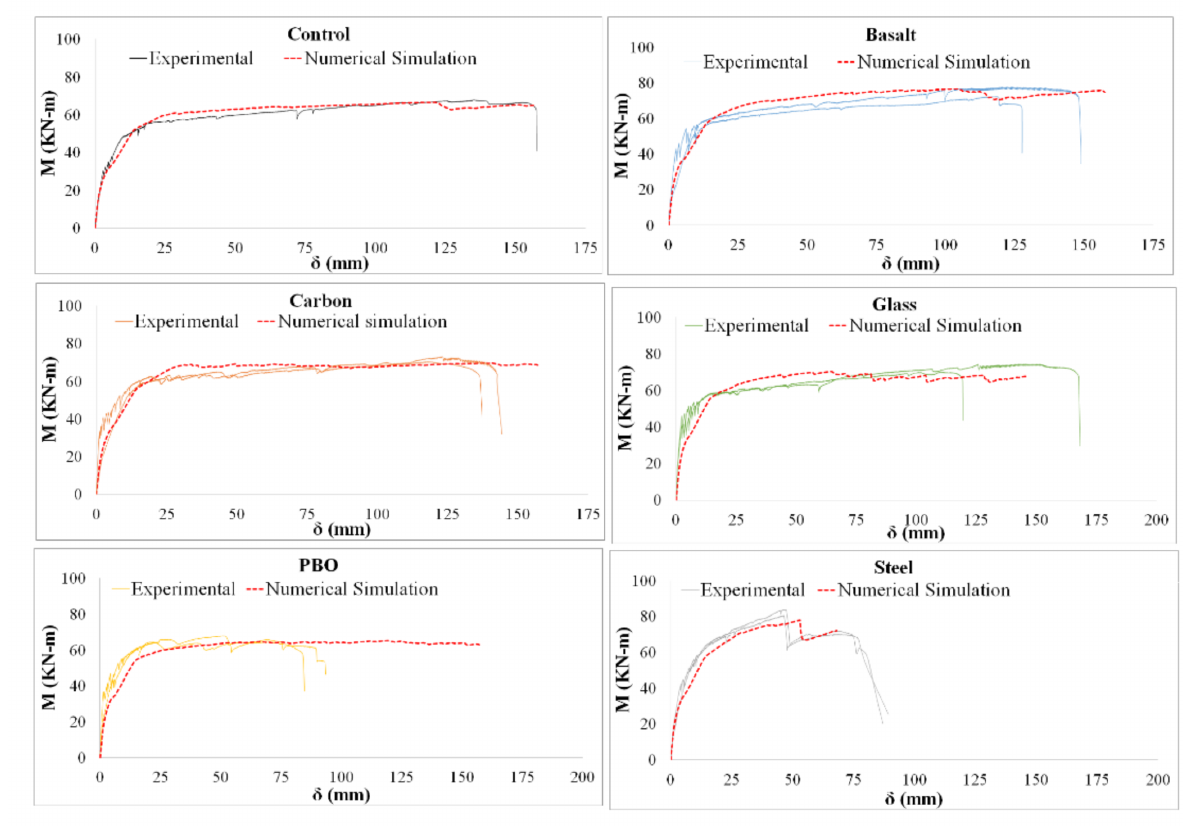
Figure 9. Moment–deflection diagrams.